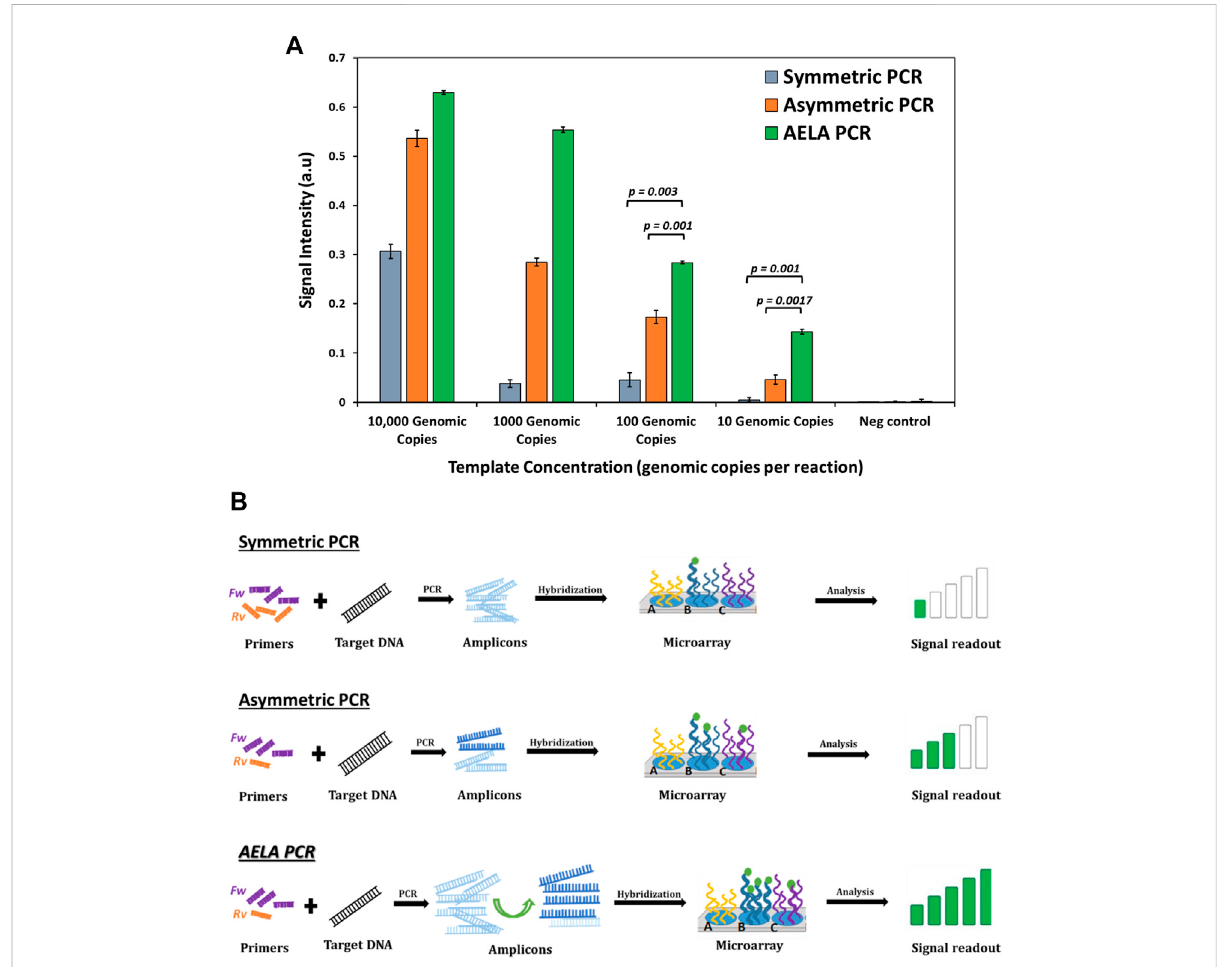
FIGURE 5 Comparison of conventional, asymmetric and AELA PCR: (A) Signal intensities for Staphylococcus aureus probe obtained after ampli fi cation of Staphylococcus aureus copy number dilutions with different PCR pro fi les and hybridizing the amplicons on to the microarray. The “ p -values ” shows the signi fi cance for t -test for null hypothesis, which means any value ≤ 0.05 is signi fi cant. (B) Schematic representation of microarray signal readout with different PCR pro fi les. The body of primer sequence used for the three PCR pro fi les is the same but as shown in Figure 1 the AELA PCR has an extended self-complimentary sequence to its 5 ′ end. The primers are used at equal concentrations for the symmetric PCR but used at 20: 1 concentrations for asymmetric and AELA PCR